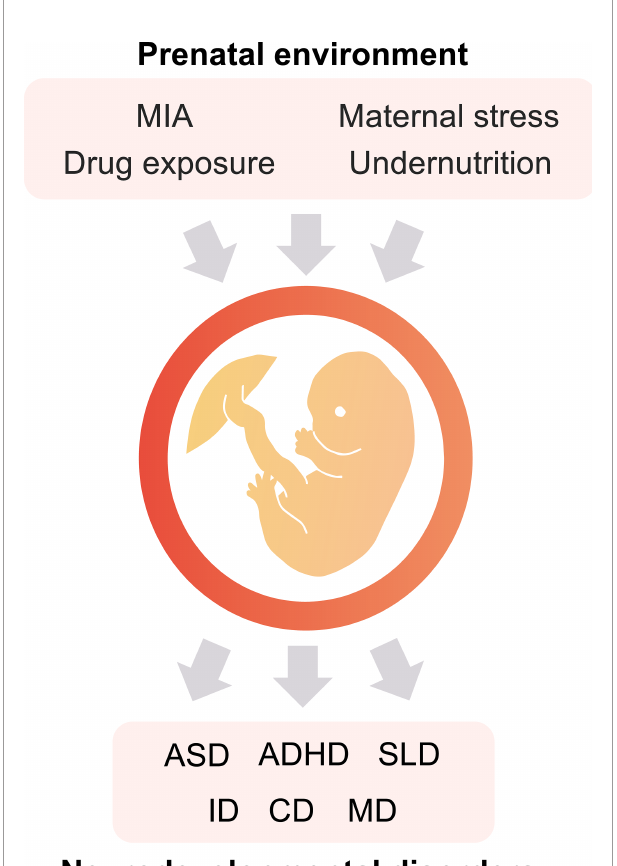
FIGURE 1 | The prenatal environment impacts the offspring ’ s health. Maternal immune activation (MIA), exposure to speci fi c drugs, maternal stress, and undernutrition during the fetal period are potential risk factors for the onset of neurodevelopmental disorders (NDDs). ASD, autism spectrum disorder; ADHD, attention-de fi cit hyperactivity disorder; SLD, speci fi c learning disorder; ID, intellectual disabilities; CD, communication disorders; and MD, motor